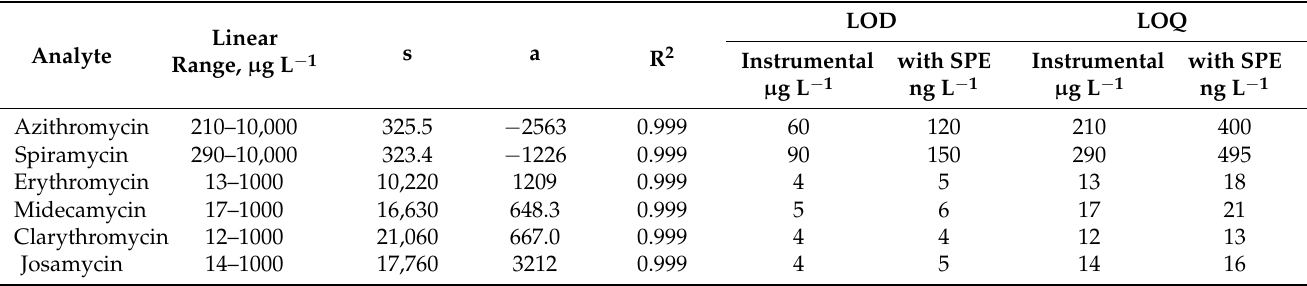
Figure 3. The HPLC-MS/MS (PrecIS) chromatogram of the model mixture of macrolide antibiotics (Azithromycin and spiramycin—500 μ g L − 1 , erythromycin, midecamycin, clarithromycin and josamycin—50 μ g L − 1 ) obtained with the detection of diagnostic product ions with m / z 174 (red) and m / z 158 (black). Table 2. Parameters of the calibration curves ( y = sx + a ) for the dependence of the chromatographic peak area ( y ) on the concentration of analyte ( x ); instrumental and method LODs and LOQs for the determination of six macrolides by HPLC-MS/MS in the PrecIS mode.